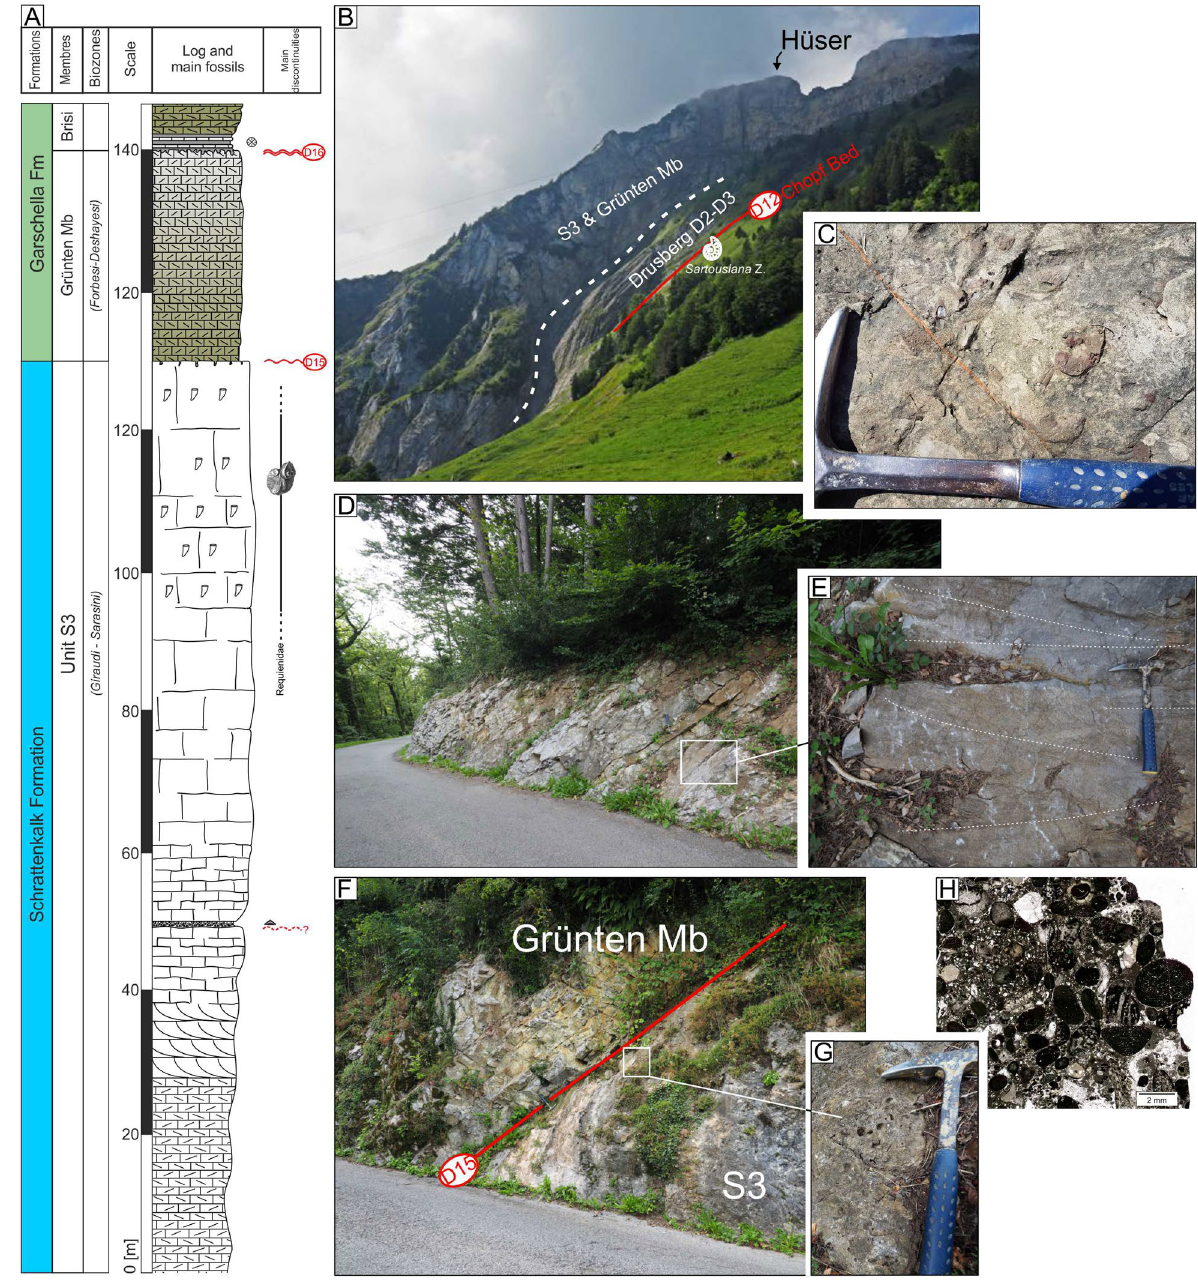
Fig. 14 A Lithological log of Mätzenacker section with discontinuity surfaces (D15 and D16). Rudist-shell drawing from Matheron (1842). B South westward view from Vorderalp (Frümsner Alp) on the Hüser cliff along the south eastern anticline. The succession is composed of marlstones of the upper part of Drusberg Member (D2; Tierwis Formation pro parte) transforming into a succession of carbonates of the Schrattenkalk Formation and the Grünten Member (Garschella Formation pro parte). C Focus on the glauconitic Chopf Bed and its phosphatic ammonites in Alp Wis. D View of the irregularly bedded, bioclastic, mostly echinodermic limestones (unit S2?–S3) along the Brunnenberg road at Mätzenacker. E Focus on the cross-stratification inside the echinodermic limestones. F Contact between the Schrattenkalk unit S3 and the Grünten Member along the Brunnenberg road at Mätzenacker. G Focus on the bored firmground surface D14. H Thin section in the bioclastic limestone of the Grünten Member, characterized by its glauconite gains and abundant orbitolinids, Bergli